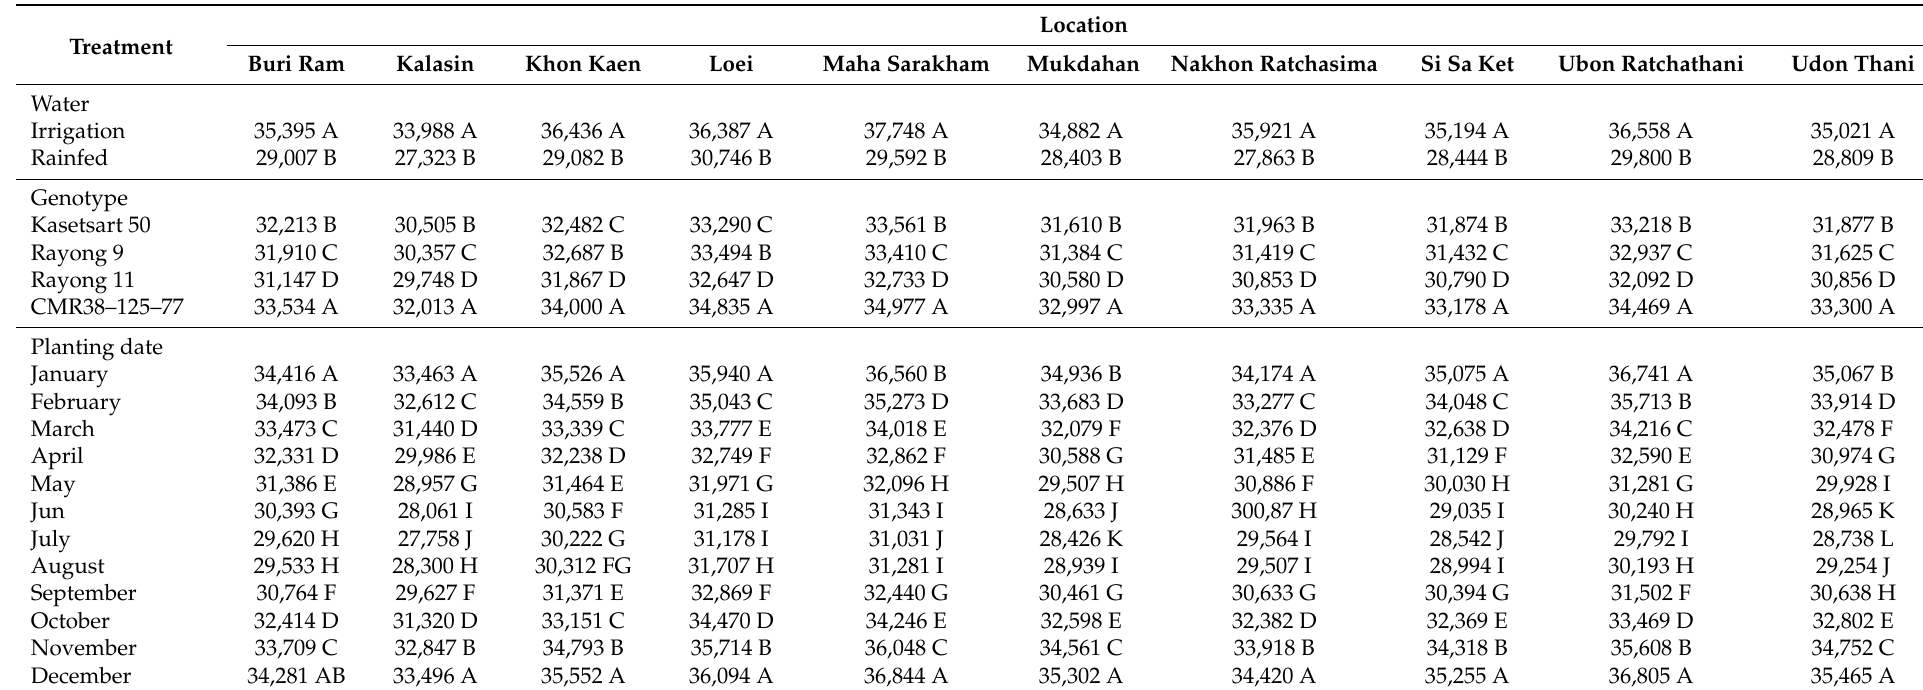
Table 3. Simulated total dry weight (kg ha − 1 ) for different treatment scenarios over 30 years (from 1988–2018) in ten locations in northeast